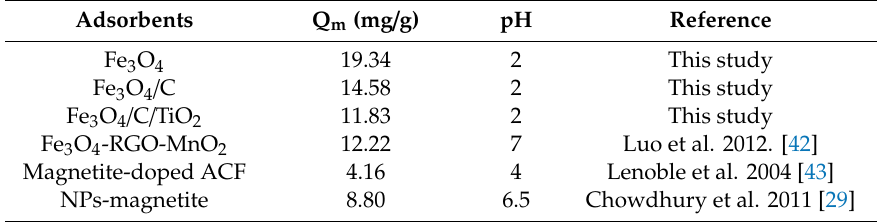
Table 4. Comparison of monolayer adsorption capacity of As(V) on different adsorbents. Adsorbents Q m (mg/g) pH Reference Fe 3 O 4